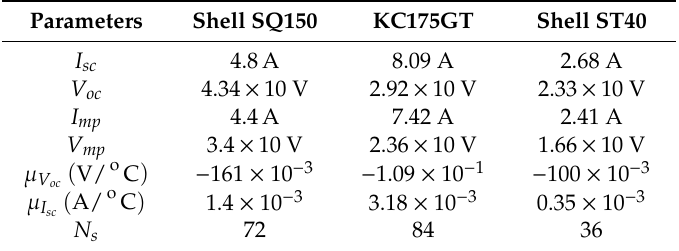
Table 1. Summary of datasheet parameters of the PV modules used in this work at STC.